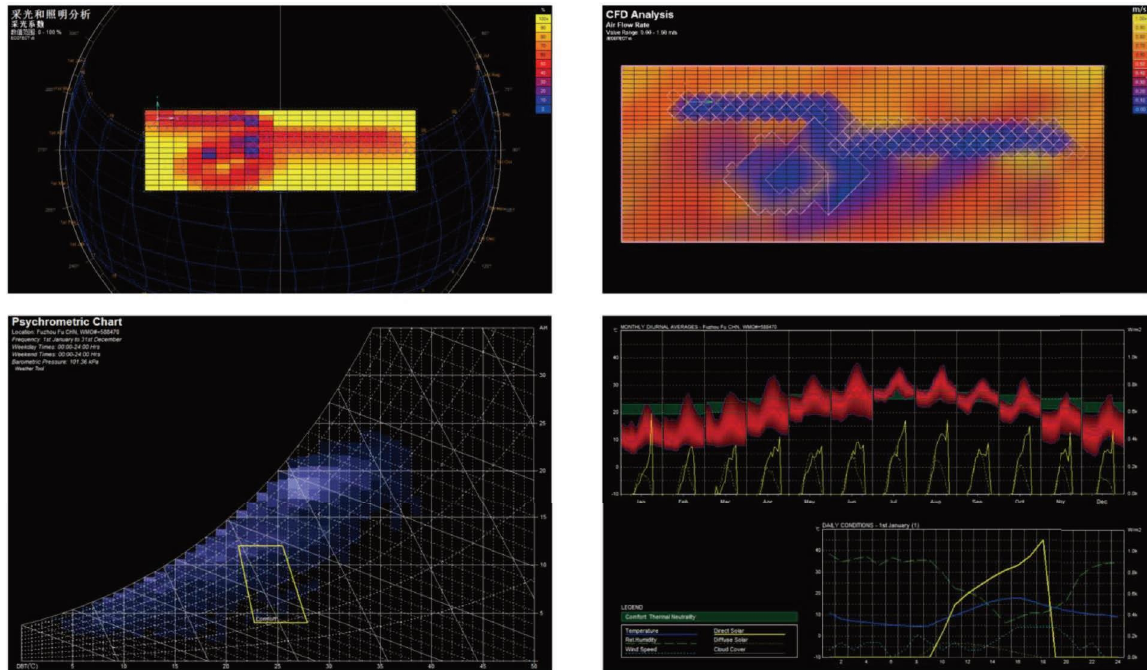
Figure 8: Analysis of greening of container buildings (Zhangzhou Shuangyu island